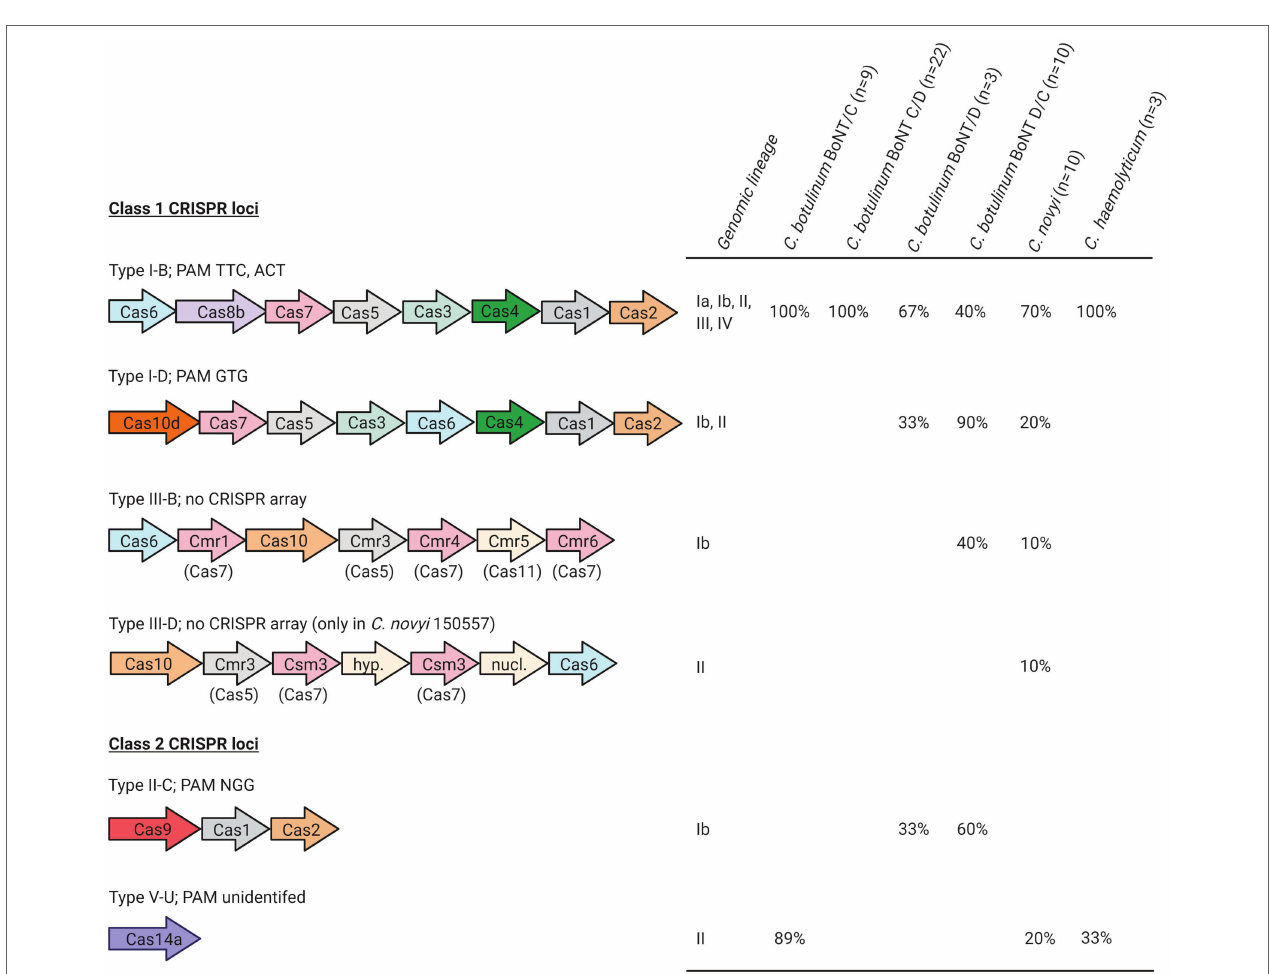
FIGURE 1 | Clostridium novyi sensu lato CRISPR types. CRISPR types were identified throughout Clostridium novyi sensu lato genomes using the CRISPRCas++ server (Couvin et al., 2018). Cas genes are shown according to their original order in the genome sequences, in accordance with the literature (Koonin et al., 2017). Created with